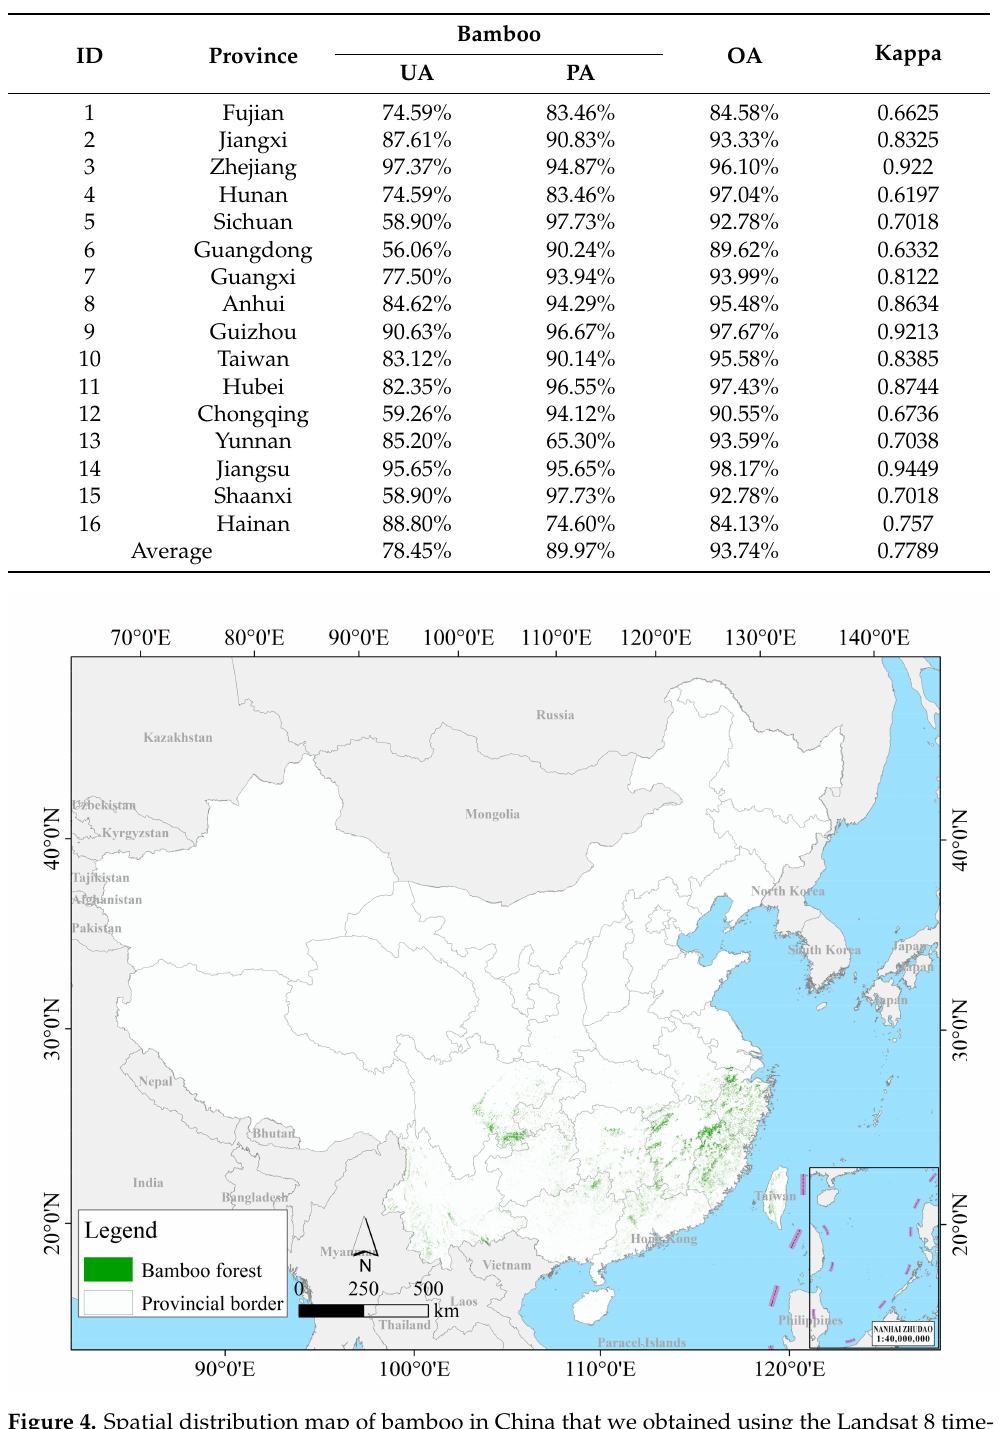
Table 5. The average of 50-fold cross validation results in this study.